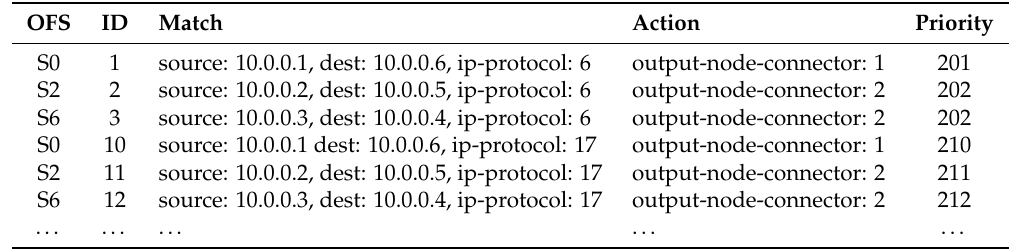
Table 2. Flow rules configuration example for each